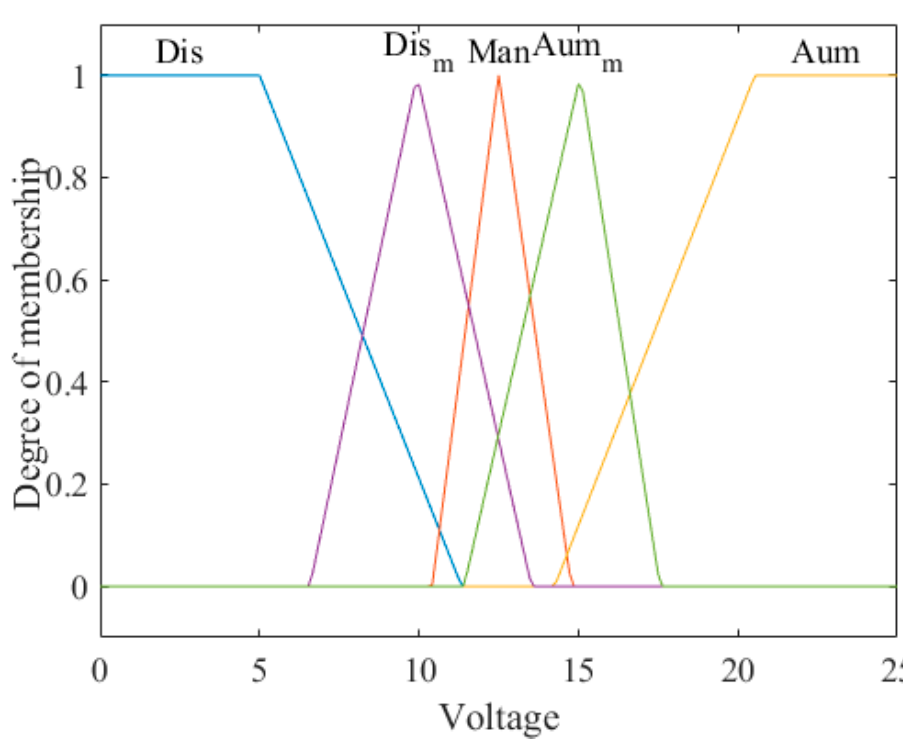
Figure 10. Output for the FLC with step speed reference.